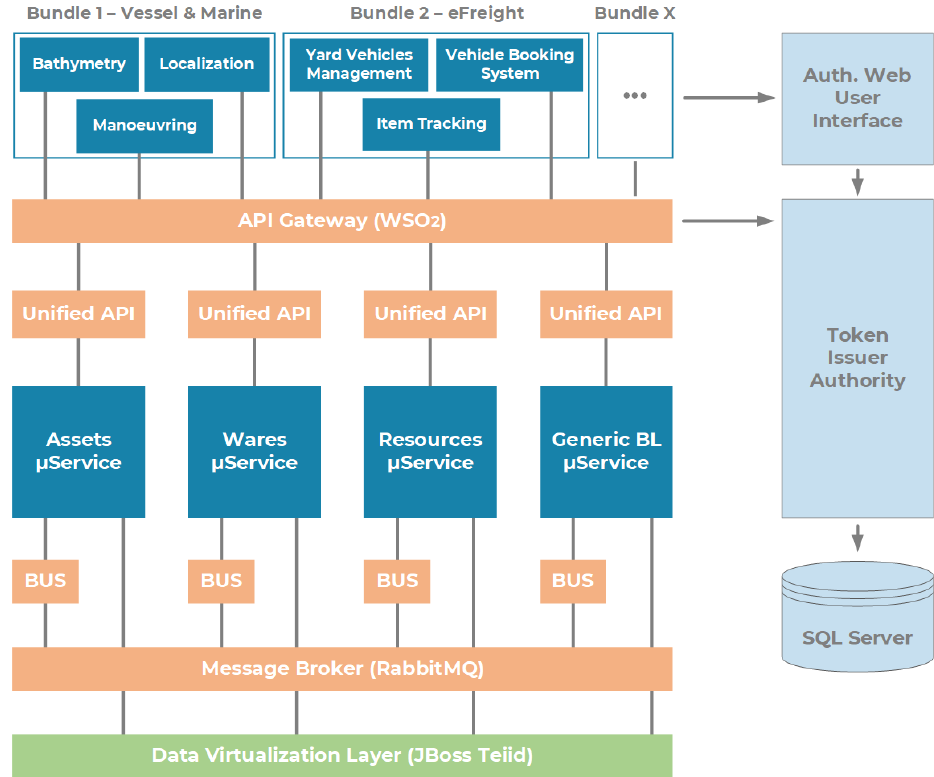
Figure 5. A microservice-based architecture for the SaaS layer of the MONICA